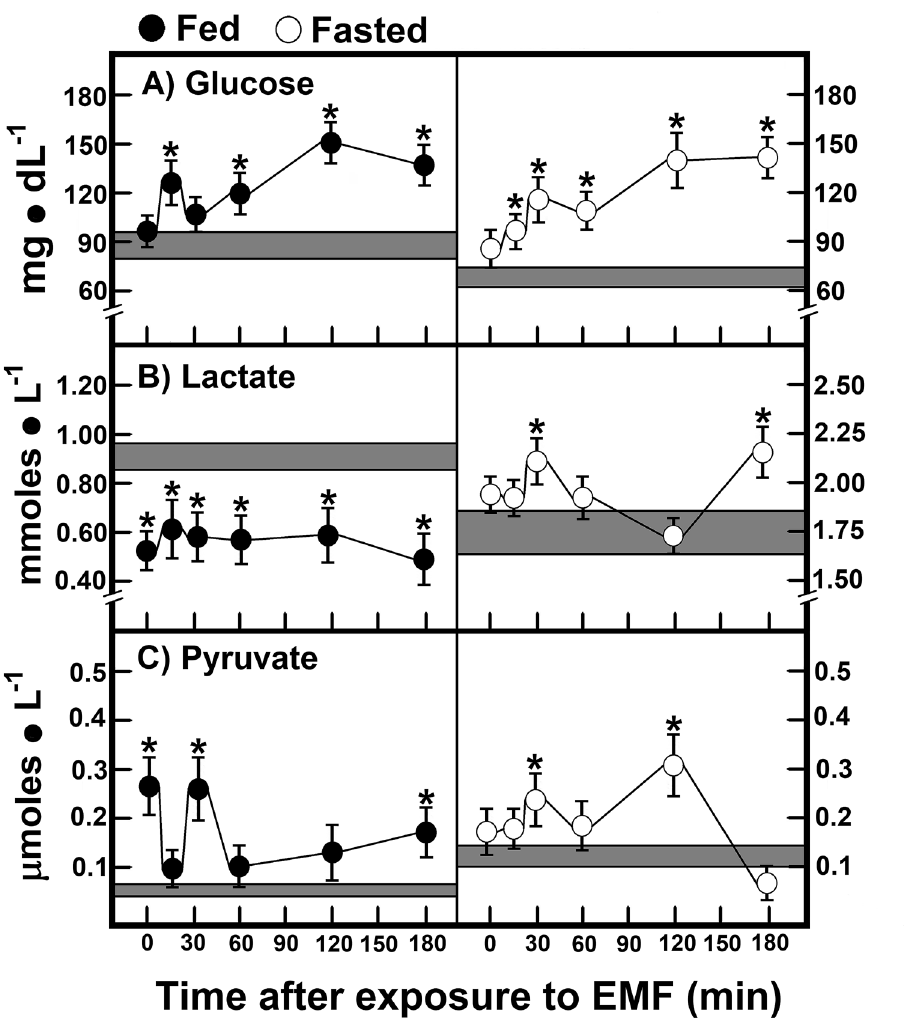
Figure 2. Time-course of EMFs’ effects on glucose, lactate, and pyruvate in fed and fasted rats. Results are the mean ± SE of three individual observations per experimental group and point (6 control animals vs. 6 treated rats), for glucose (panels A), lactate (panels B), and pyruvate (panels C). Experimental groups are designated by symbols at the upper part of the figure. Statistical significance: * p < 0.01 versus control